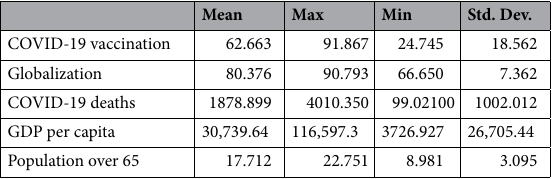
Table 1. Descriptive statistics.